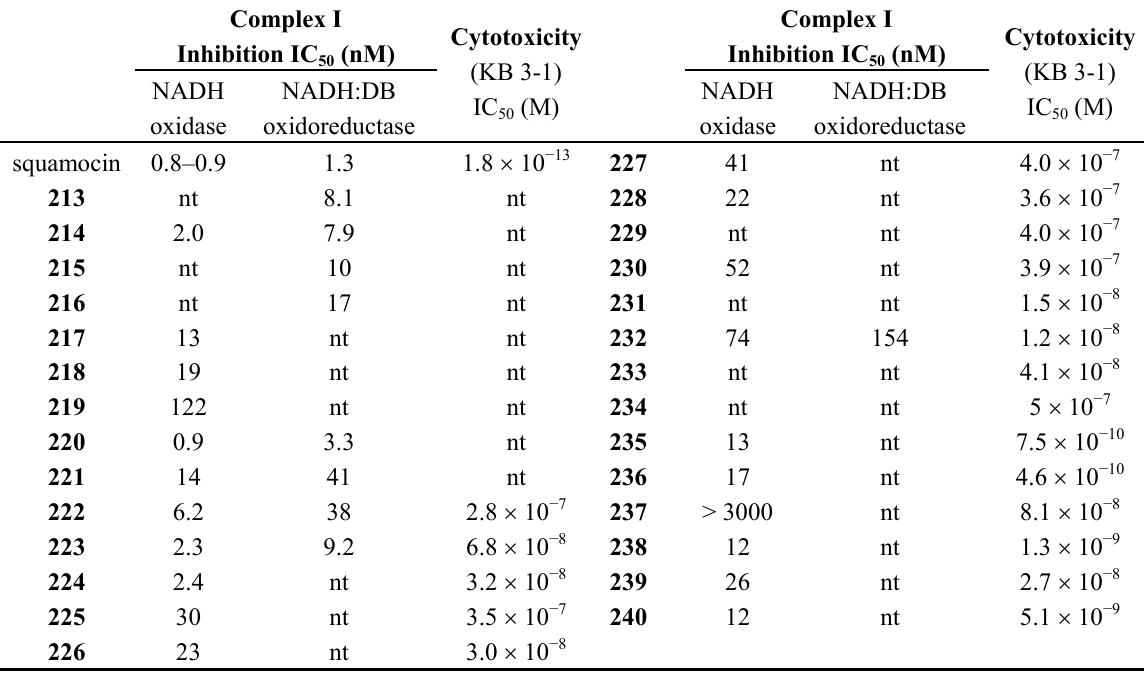
Table 17. Biological activities of squamocin